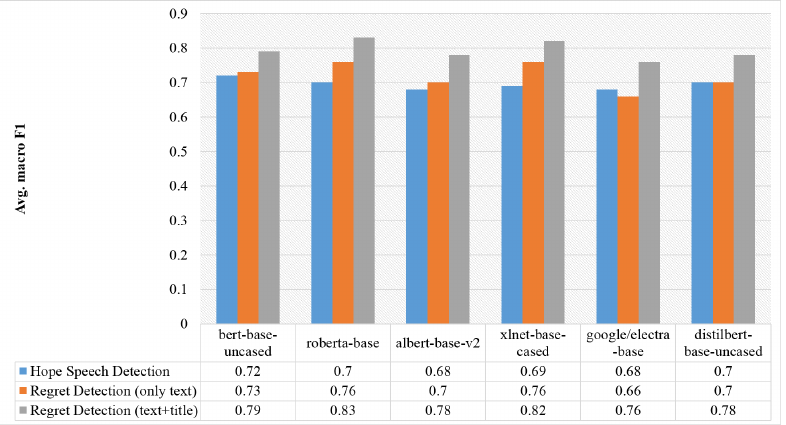
Figure 3. Comparison of the performance of different transformers between regret detection and multi-class hope speech detection